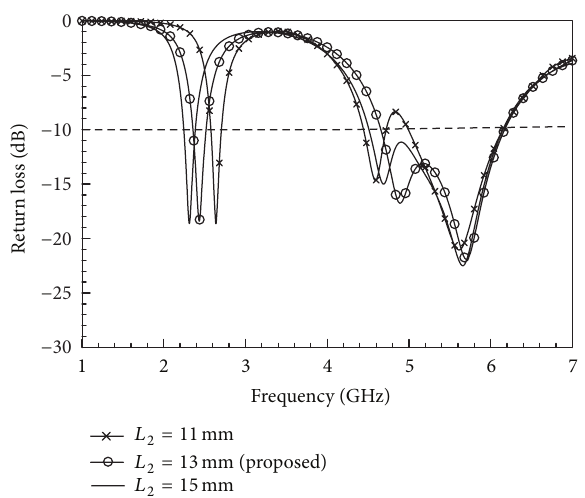
Figure 4: Simulated return loss versus frequency for various 𝐿 2 ; 𝐿 1 is fixed as 7.5 mm and 𝐻 = 3 mm.